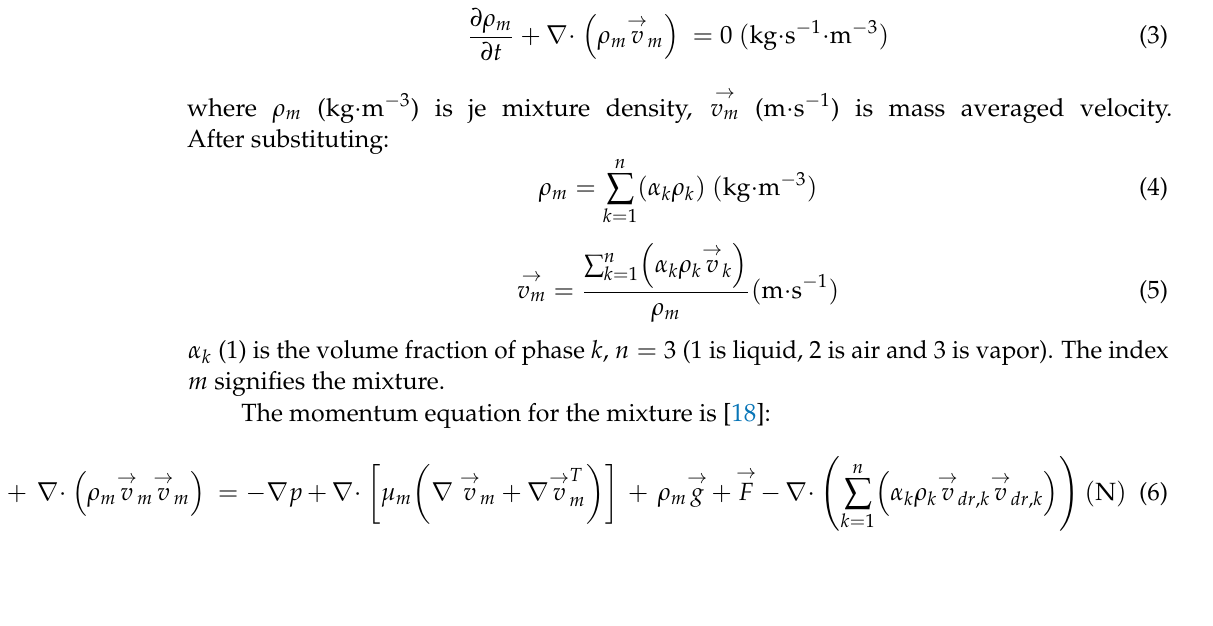
Table 1. Basic dimensions (mm), see Figure 3.